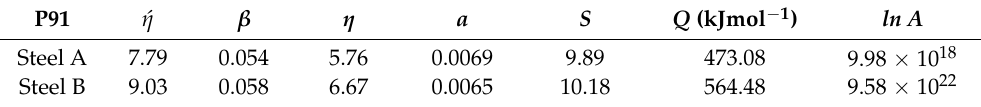
Table 2. Material constants and activation energy for steel A and steel